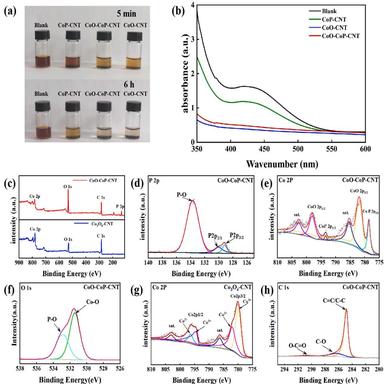
(a) Adsorption experiments of CoO-CoP-CNT, CoO-CNT and CoP-CNT materials Li2S6 and (b) UV–visible light absorption spectra of the supernatant after standing for 6 h. (c) Total XPS spectra of CoO-CoP-CNT compared with Co3O4-CNT, (d) Co 2p high-resolution spectra of CoO-CoP-CNT (e) Co3O4-CNT; The (f) P 2p, (g) O1s, (h) C 1 s high resolution spectrum of CoO-CoP-CNT.